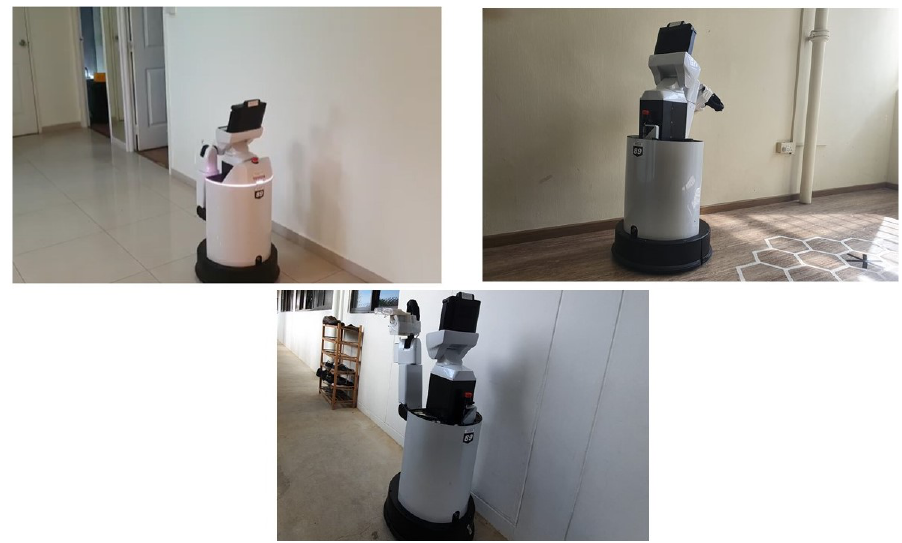
Figure 16. Experimental Scenario-1 ( top left ), Scenario-2 ( top right ), Scenario-3 ( bottom ).